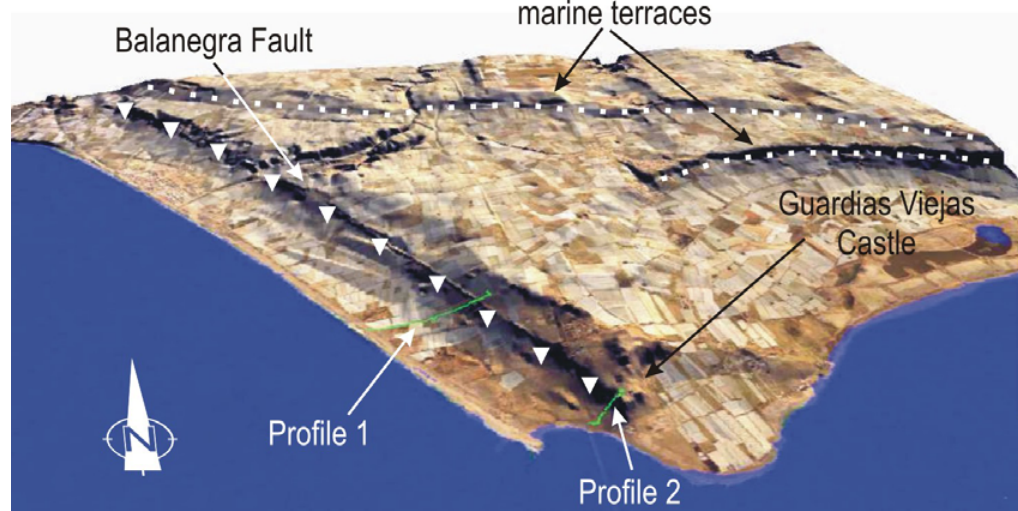
Figure 4. Digital terrain model of Balanegra Fault Zone showing the fault scarp and marine terraces (10  10 m). Vertical exaggeration has been applied for a better